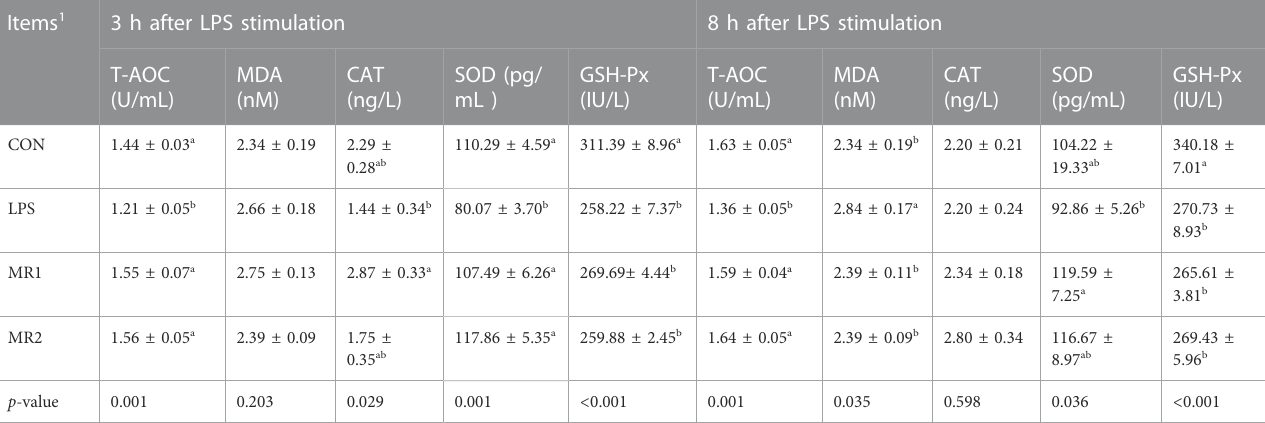
TABLE 7 Effects of dietary methionine restriction on serum antioxidant capacity of LPS-stimulated broilers (n = 6). Items 1